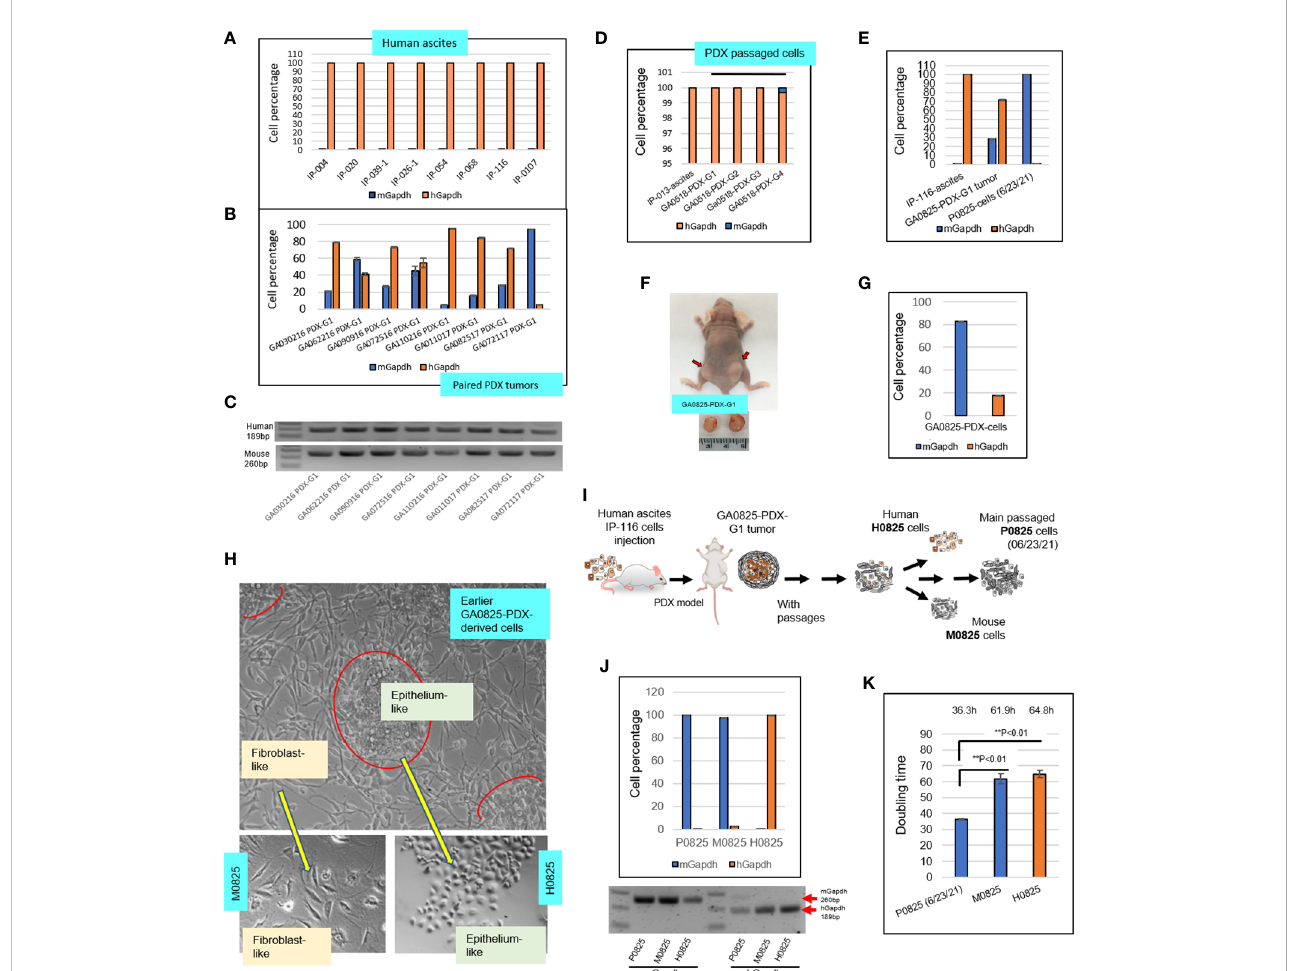
FIGURE 2 Intronic genomic qPCR quanti fi cation of human ascites and their paired PDX tumors, and further investigation on transformation of a PDX model GA082517-PDX-G1. (A) Intronic qPCR quanti fi ed compositions of eight human ascites. (B) Intronic qPCR quanti fi ed compositions of the PDX tumors paired to the eight ascites in A, showing different levels human and murine cell percentages. (C) qPCR end products were visualized on agarose gels, showing human amplicon 189bp and murine 260bp. (D) qPCR quanti fi cation of composition in four passaged cells of GA051816-PDX-G1, -G2, -G3 and -G4 in SCID mice. (E) Intronic qPCR quanti fi cation was applied to a special case of GA082517-PDX-G1, its composition completely turned over from the human ascites IP-116 to PDX and to its derived cells P0825 (6/23/2021). (F) Human gastric cancer patient IP-116 ascites were injected into a nude mouse to generate GA082517-PDX-G1 at time of sacri fi ce. (G) Intronic qPCR quanti fi ed cell composition of an in vitro growing cells derived from GA0825-PDX- G1. (H) Micrographs of the cells in G showed that there were two types of morphologically different cells, from which single-cell pools of epithelium-like H0825 and fi broblast-like M0825 were isolated. (I) An illustration of the GA0825-PDX-G1-derived cells showed how the lineage diverged into H0825, M0825 and the cells passed on to main passaged P0825 (6/23/21). (J) Intronic qPCR quanti fi ed the compositions of three subpopulations human H0825, murine P0825 and M0825, their PCR end products were visualized on an agarose gel. (K) Doubling times were measured for three subpopulations human H0825, murine P0825, and M0825